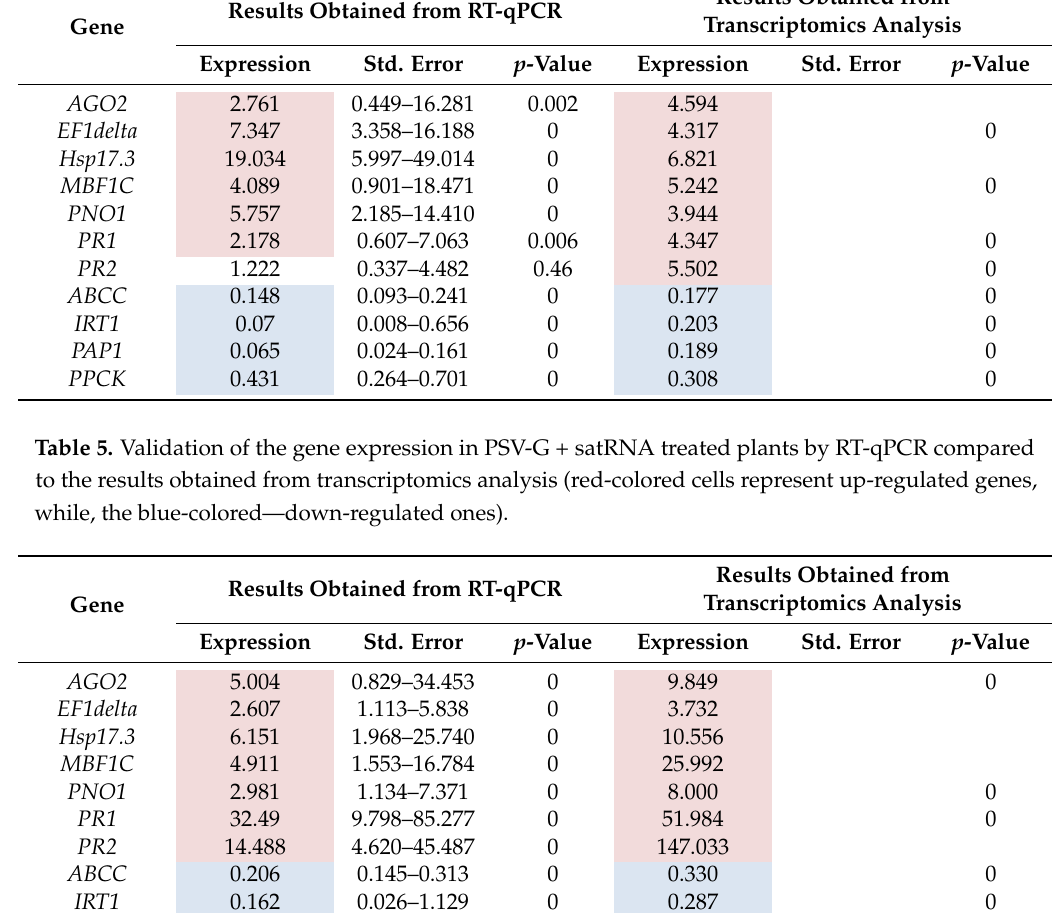
Table 4. Validation of the gene expression in PSV-G treated plants by RT-qPCR compared to the results obtained from transcriptomics analysis (red-colored cells represent up-regulated genes, while, the blue-colored—down-regulated ones).